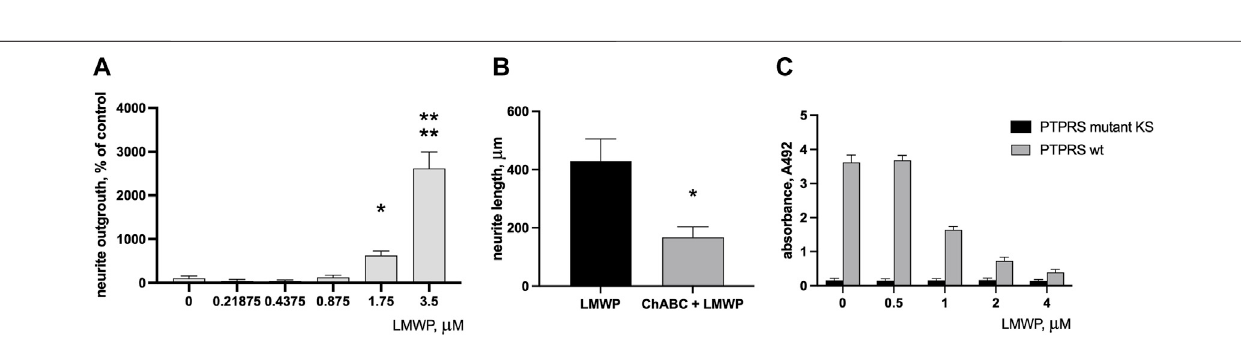
FIGURE5| EffectofLMWPonneuriteoutgrowthonaggrecansubstrateandonbindingofPTP σ (PTPRS)toaggrecan. (A) Neuriteoutgrowthincorticalneuronson the aggrecan substrate in the presence of increasing concentrations of LMWP added in the culture medium. (B) Effect of CS digestion of the aggrecan substrate by chondroitinase ABC (ChABC) on neurite outgrowth on the aggrecan substrate in the presence of 4 µM LMWP. (C) Inhibition of PTP σ binding to aggrecan substrate by increasingconcentrationsofLMWPinthetestmedium.* p < 0.05,**** p < 0.0001,unpairedt-testorANOVAfollowedbyFisher ’ sLSDtestformultiplecomparison; n =